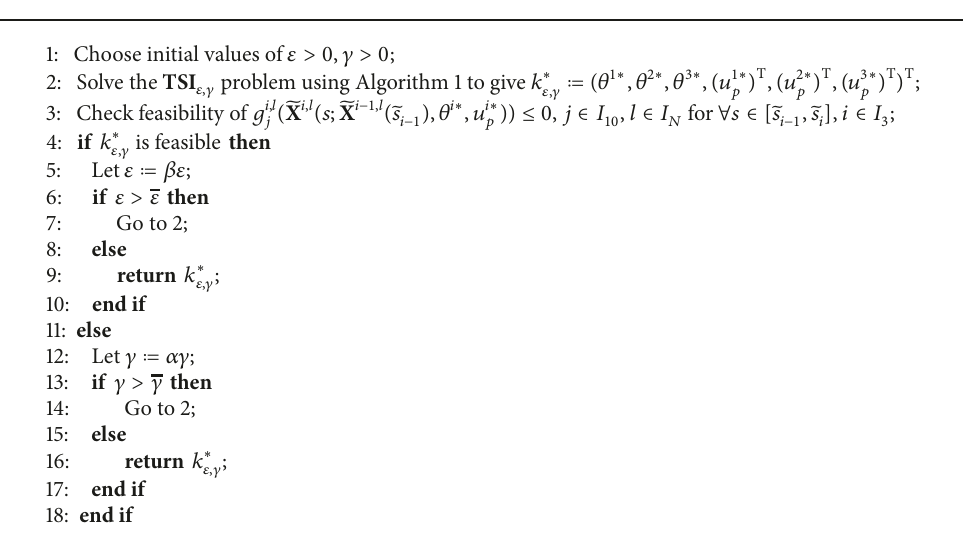
Algorithm 3: Combining Algorithms 1 and 2 with Theorem 8, the RIP problem can be solved by the